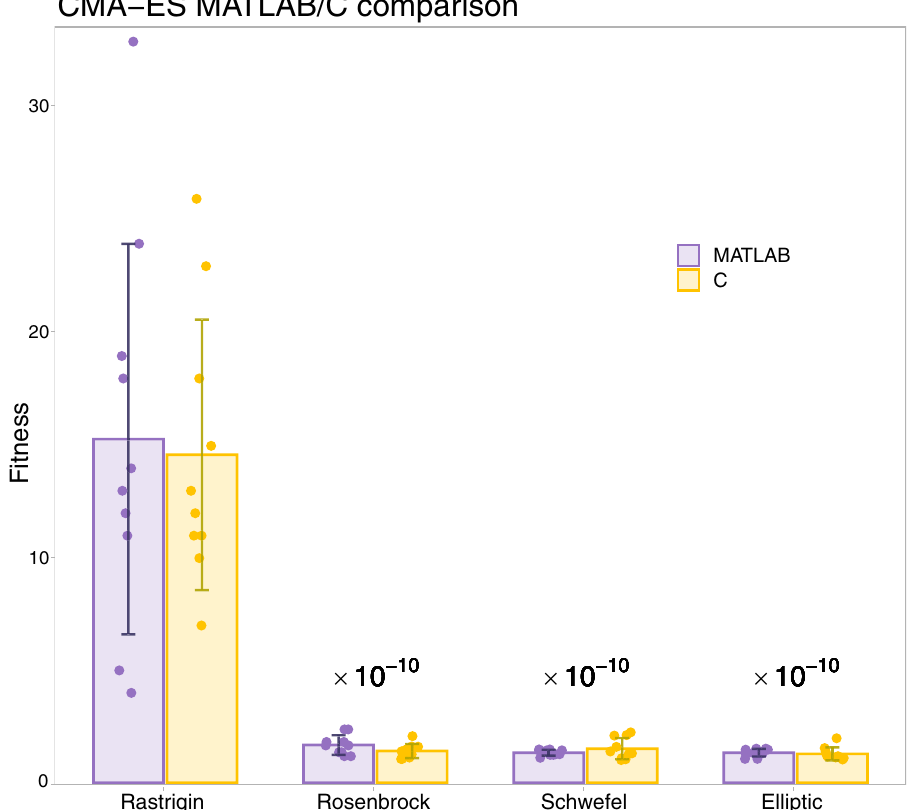
Fig. 5 Correctness of the evolutionary optimization CMA-ES algorithm translation. Average and standard deviation over ten executions of the CMA-ES fi tness algorithm for some typical benchmark functions ran in MATLAB and QSPcc-generated C code. The times of the three benchmark functions of the right are multiplied by 10 − 10 to keep them all on the same